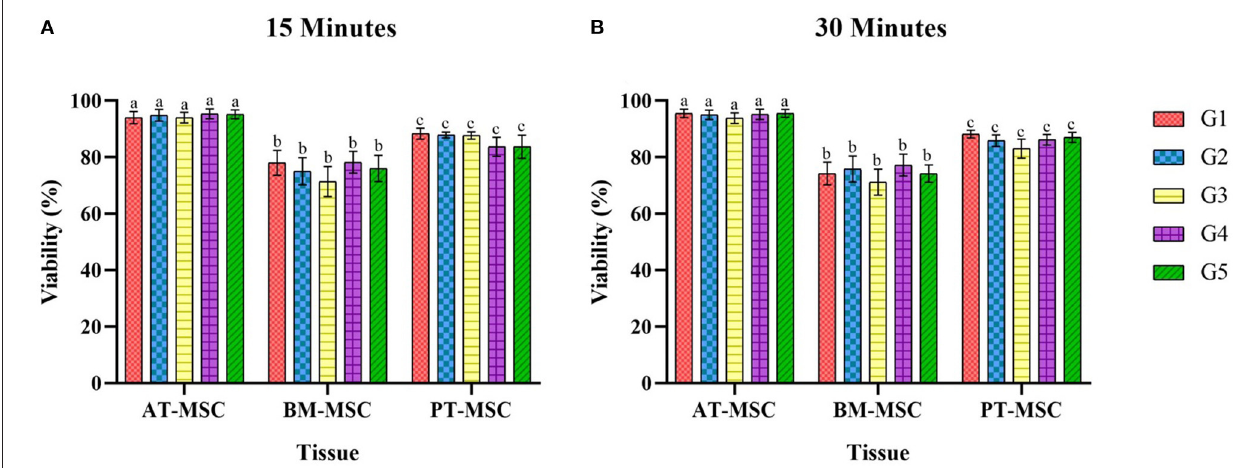
FIGURE 4 | Average viability (%) ± SEM of bovine fetal adipose tissue (AT-MSC), bone marrow (BM-MSC), and placenta (PT-MSC) mesenchymal stem cells exposed to cryoprotectant solutions for 15 and 30min [ (A,B) , respectively]. G1 corresponds to the control group without cryoprotectants. (a–c) Different letters indicate significant statistical differences ( P < 0.001) between groups.